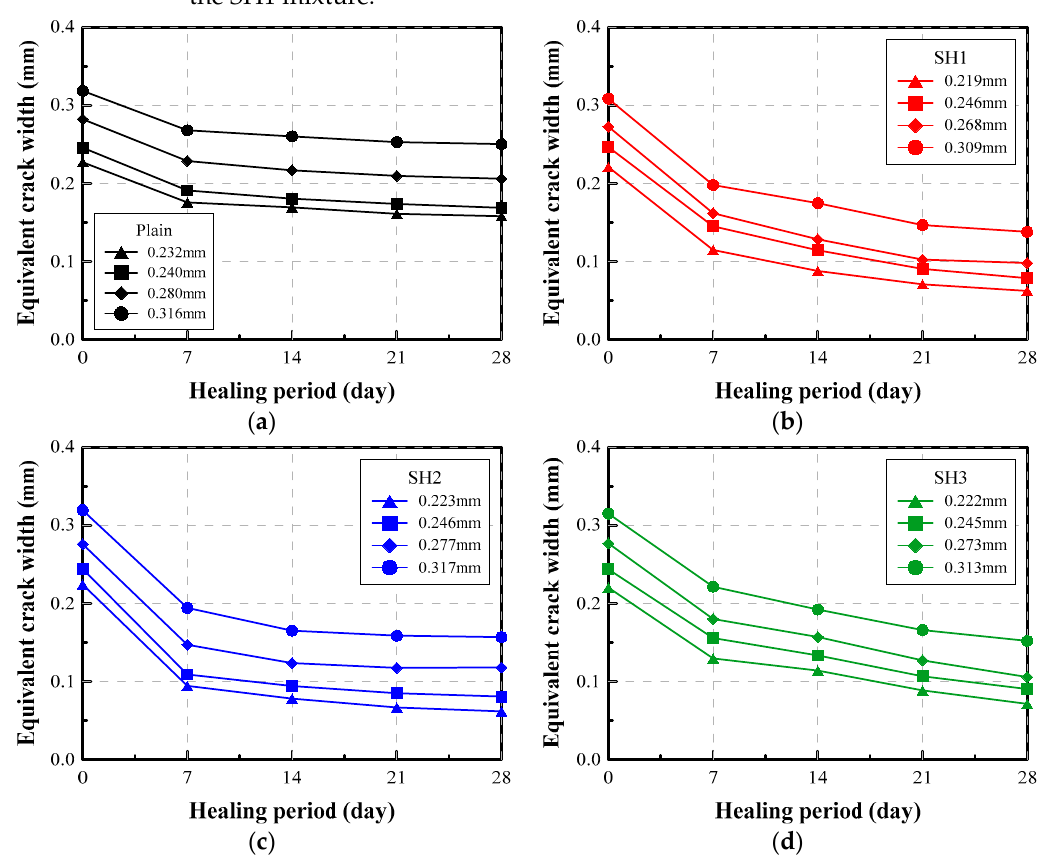
Figure 10. Equivalent crack width of selected specimens: ( a ) Plain, ( b ) SH1, ( c ) SH2, ( d ) SH3.